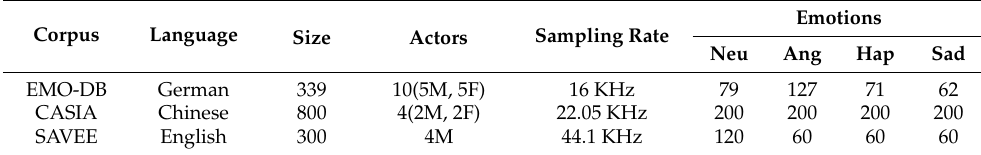
Table 1. The detailed information of corpora used in our